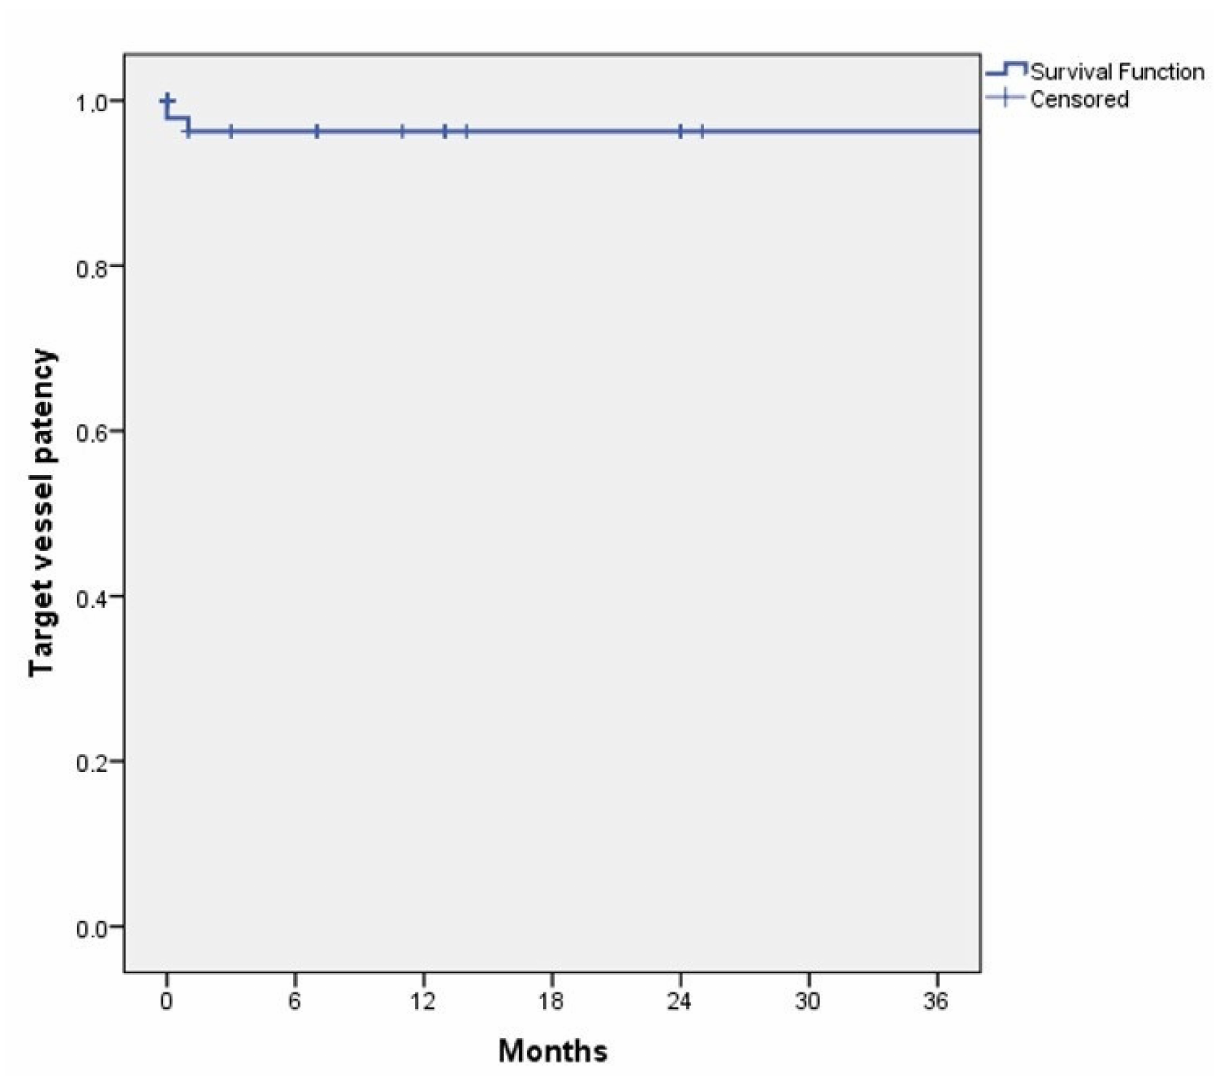
Figure 3. Kaplan–Meyer analysis of target vessel primary patency during follow-up. Three (9%) patients underwent late reinterventions. The first patient had an extension of the right graft limb for a type Ib endoleak. The second patient had a relining of an iliac graft limb due to kinking of the stent graft. The third patient underwent a reintervention with relining of the left renal artery with a covered stent due to dislocation and relining of the SMA with a self-expandable bare stent due to distal stenosis. Estimated freedom from reintervention at 12, 24 and 36 months was 95.8% ± 4.1%, 89.8% ± 6.9% and 89.8% ± 6.9%, respectively (Figure